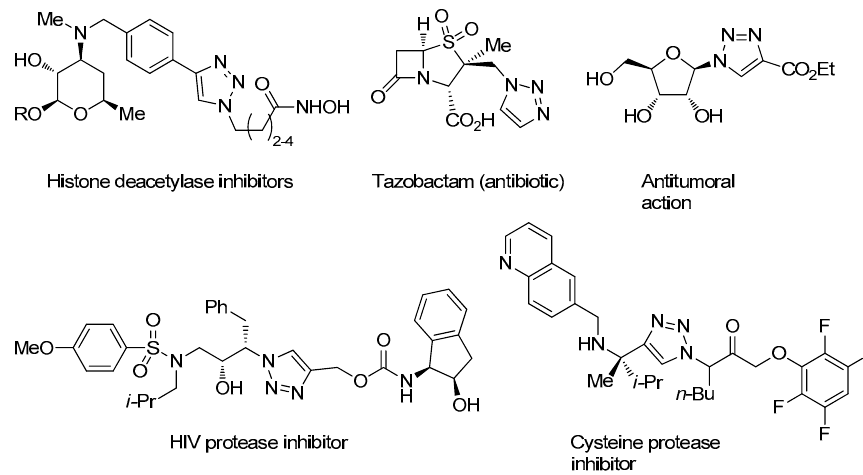
Figure 2. Selected examples of drugs and other bioactive compounds containing the 1,2,3-triazole